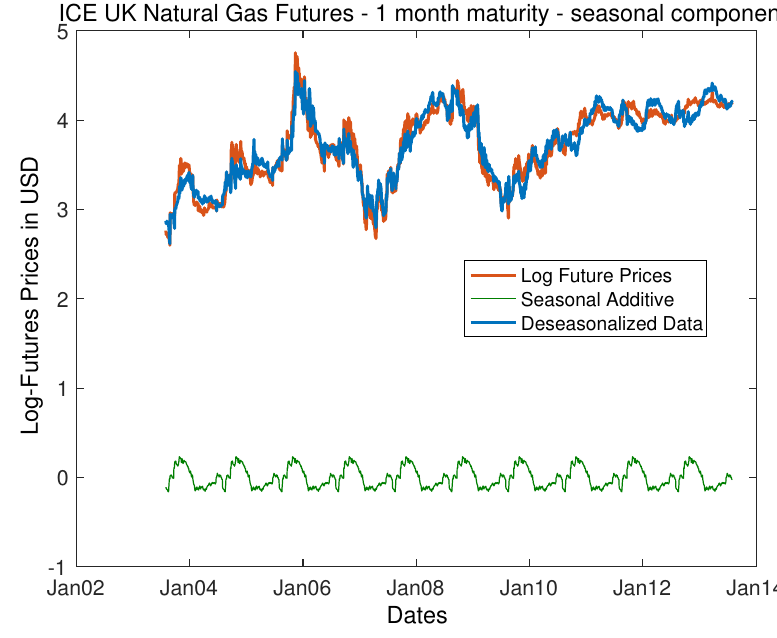
Figure 2. ICE U.K. Natural Gas Futures log-prices and deseasonalized log-prices for the one-month rolling